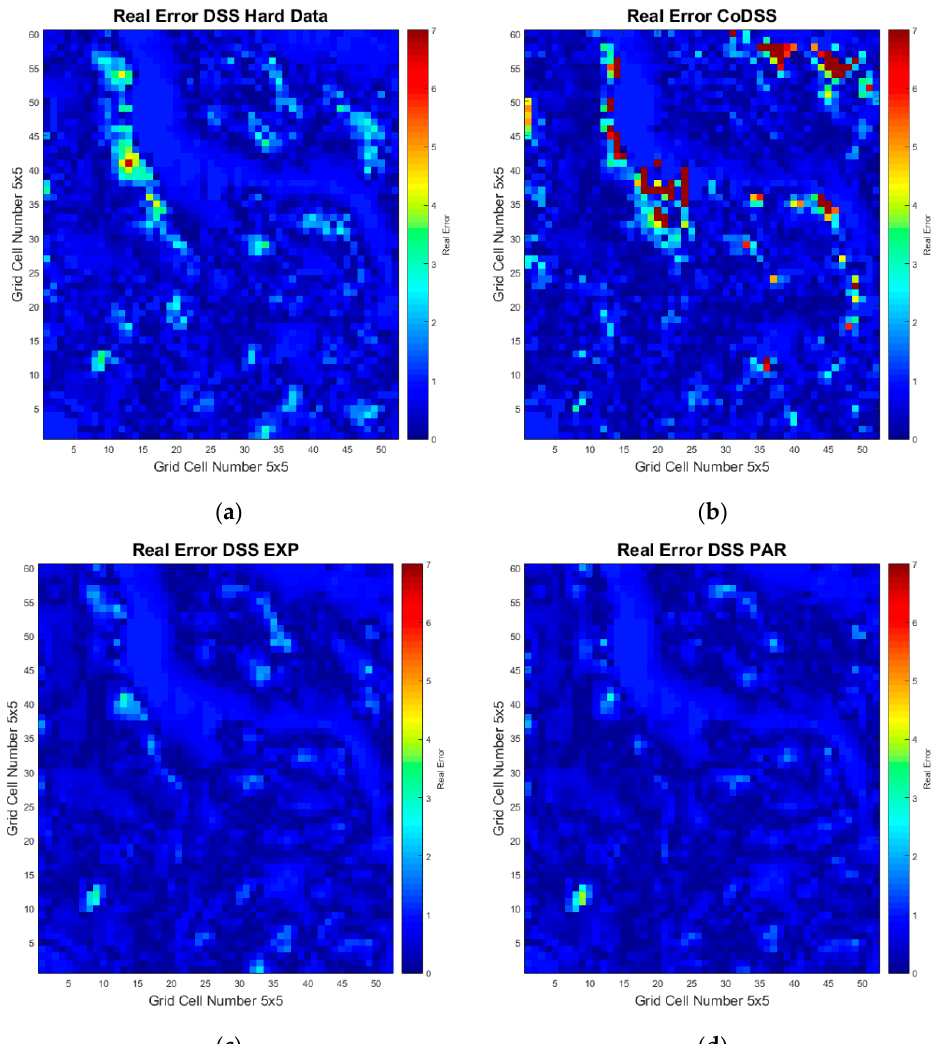
Figure 6. Map of the absolute relative errors for each simulation strategy used: ( a ) direct sequential simulation with only hard data, ( b ) direct sequential collocated co-simulation, ( c ) direct sequential simulation with experimental point distributions, and ( d ) Direct sequential simulation with local distribution functions.